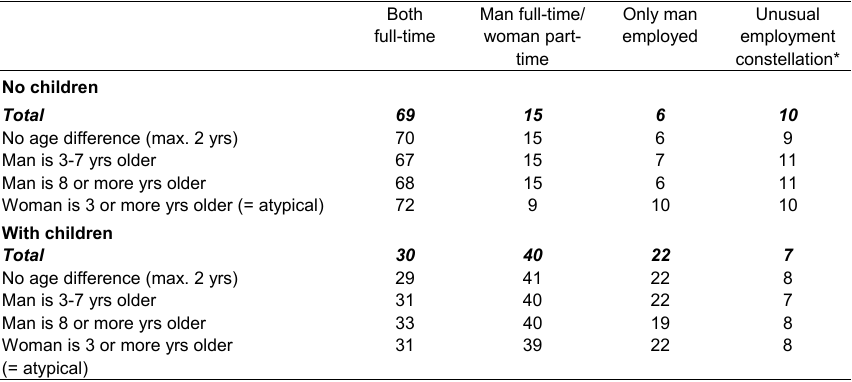
Employment constellation depending on age constellation and presence of underage children in academic couples, 2004 (in rounded row percentages)